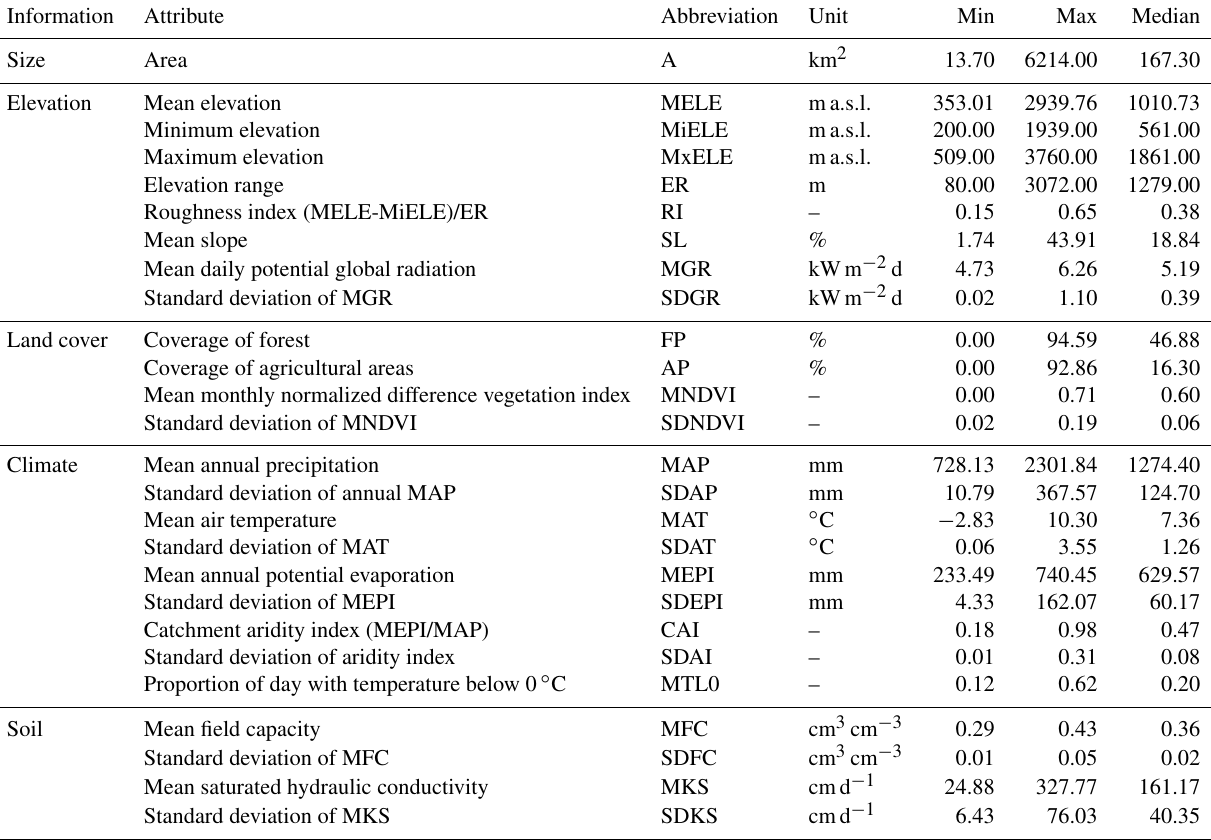
Table 1. Statistics of the catchment attributes of the 213 catchments in Fig. 1, with abbreviation, unit, minimum, maximum, and median. The standard deviations refer to spatial variability within each catchment. Note: ma.s.l. – meters above sea level.